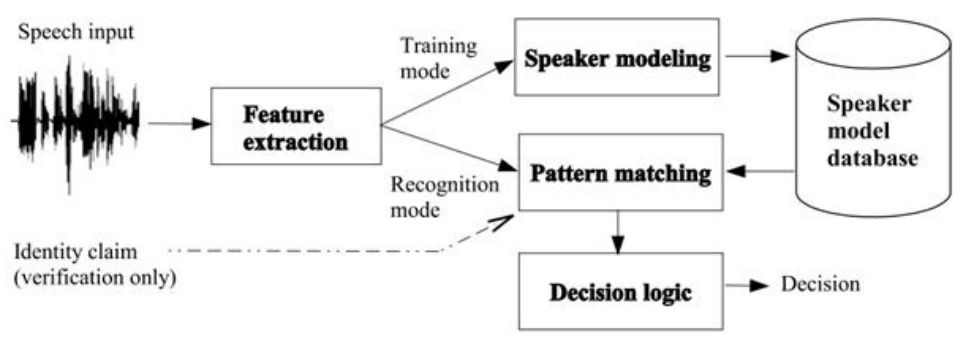
Figure 1. Speaker recognition